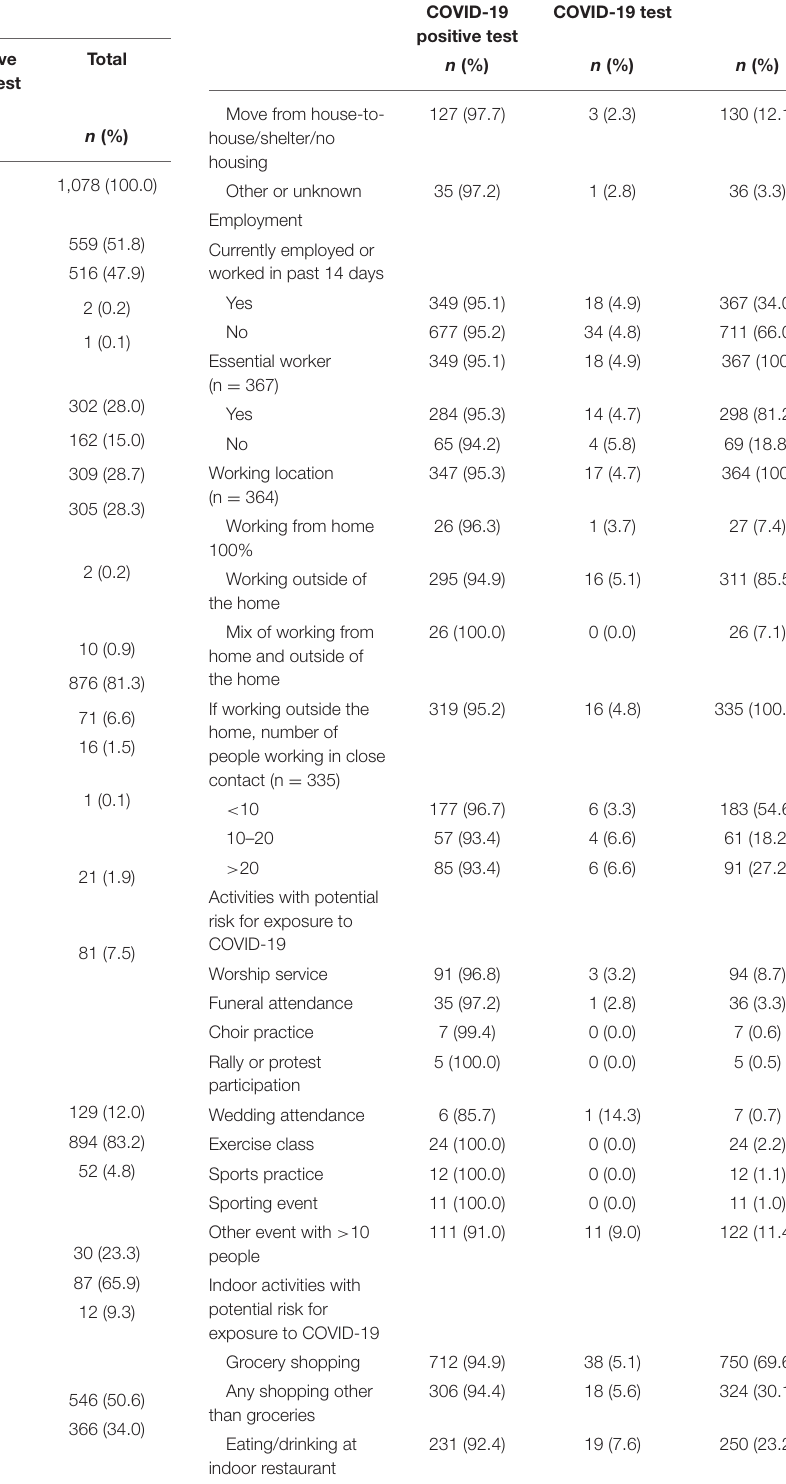
TABLE 1 | Frequency of exposures and potential risk factors for exposure to COVID-19 among persons accessing medical care and tested for SARS-CoV-2 by previous COVID-19 test result at a large urban, public hospital in Fulton County, GA, August-November